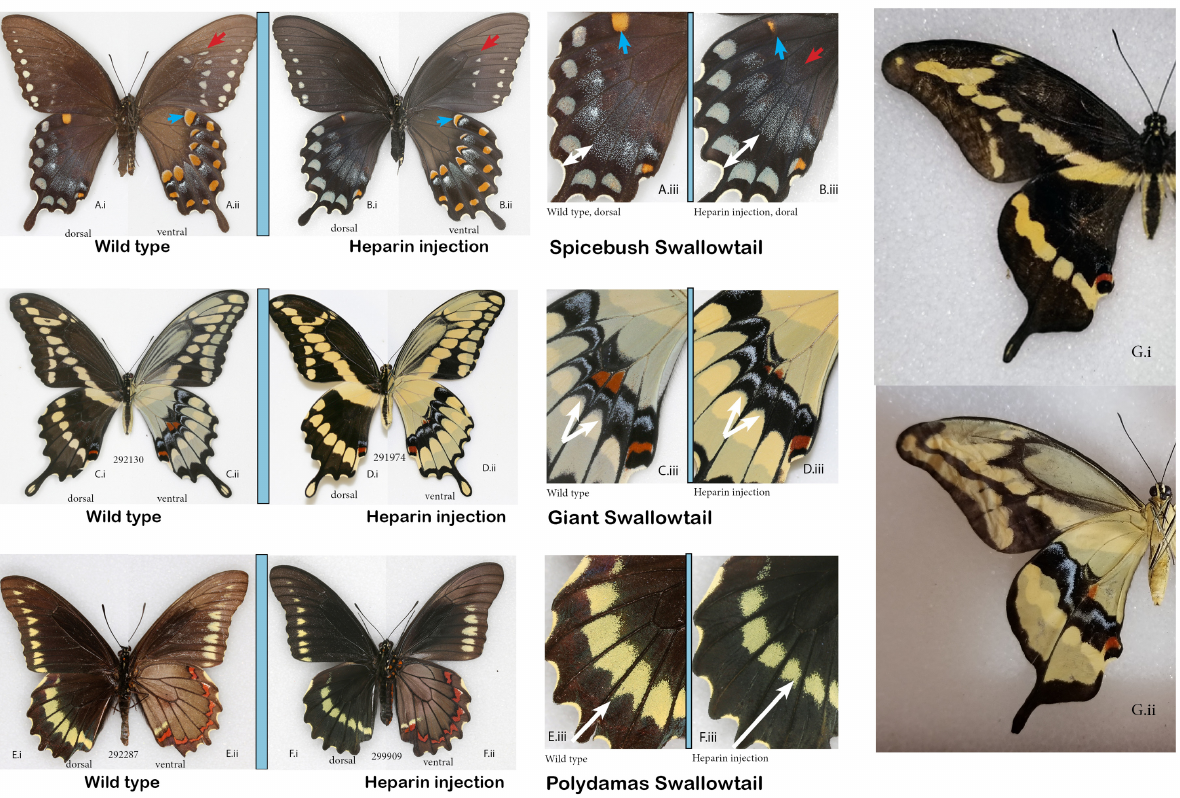
Figure 9. The normal ( A ) spicebush swallowtail, Pterourus troilus ( C ) giant swallowtail, Heraclides cresphontes and ( E ) polydamas swallowtail, Battus polydamas ( E ) vs. the corresponding individuals that underwent heparin injection as pupae ( B , D , and F ). ( G ) Aberrant giant swallowtail without veins, courtesy of Edith Smith. ( i ) dorsal, ( ii ) ventral surfaces and ( iii ) close-up of hindwings focusing on the differences. See Extended Data (Sourakov, 2020) for